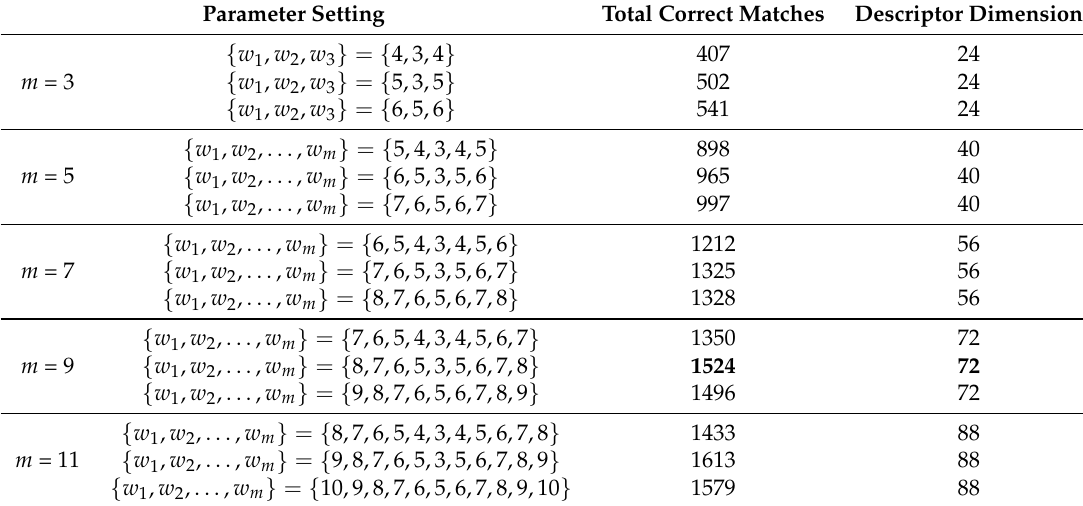
Table 1. Total number of correct matches with different parameters.